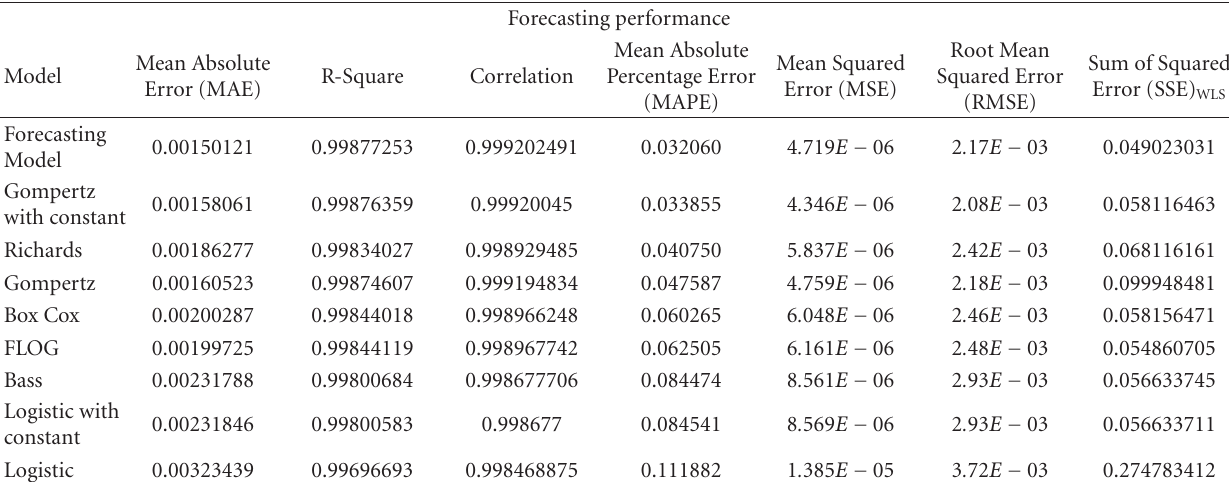
Table 4: Results of the forecasting process for the models.